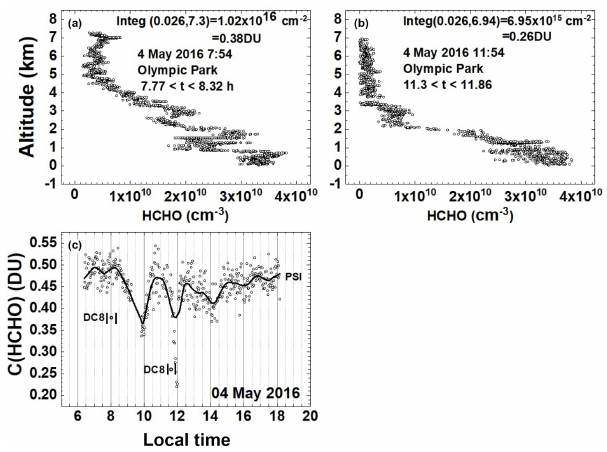
Figure 14. HCHO altitude profile measured by CAMS onboard the DC-8 on 4 May at 07:54KST (a) and 11:54KST (b) over Olympic Park, Korea. (c) PSI measurements of total column HCHO. Verti- cal bars (c) mark the DC-8 flight duration for the profiles yielding altitude integrated column amounts of 0.38 and